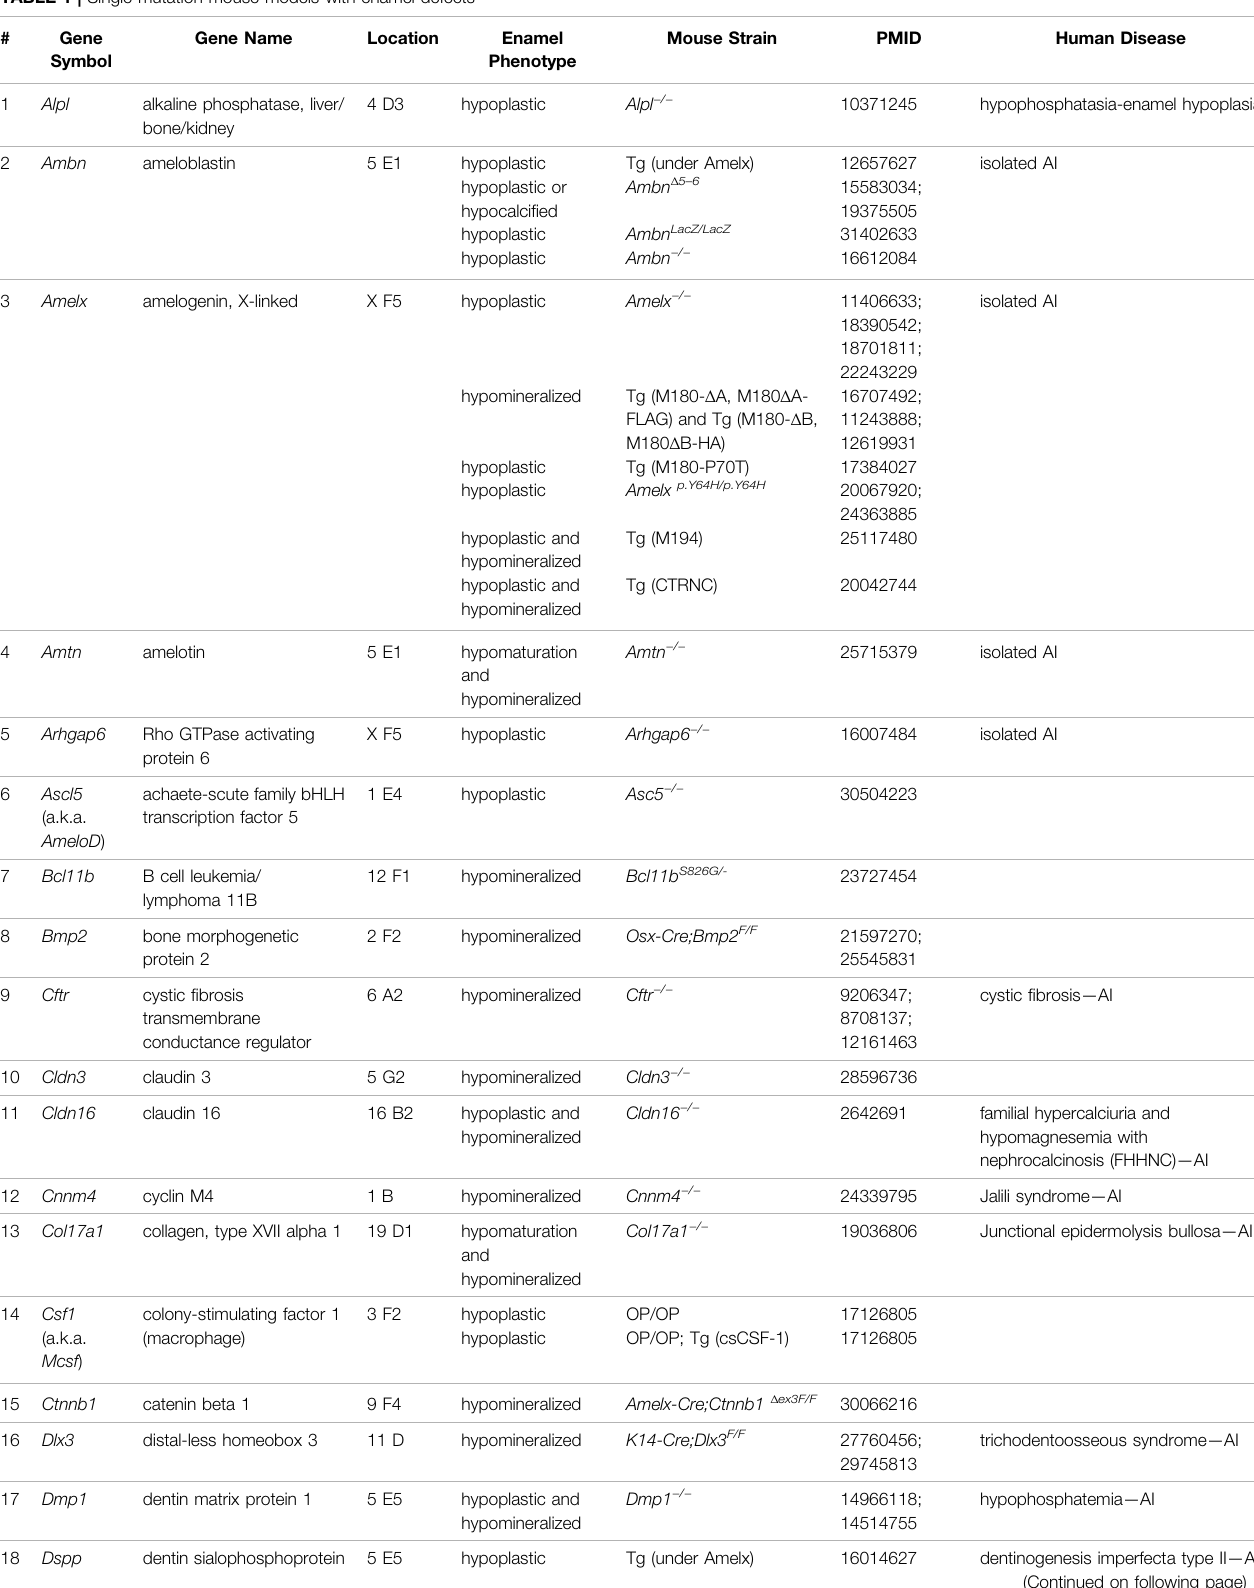
TABLE 1 | Single mutation mouse models with enamel